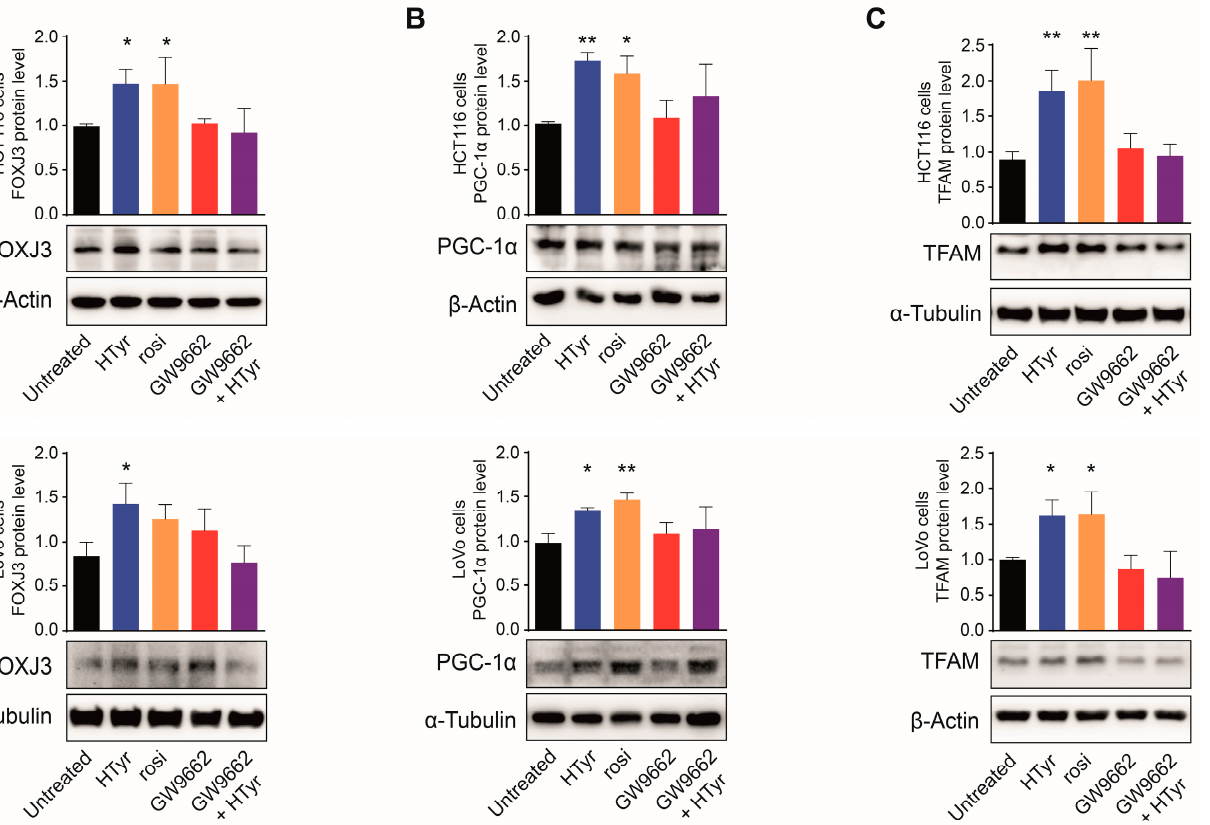
Figure 5. PPAR γ mediates the effects of HTyr on mitochondrial biogenesis. Representative im- munoblots of FOXJ3 ( A ), PGC-1 α ( B ), and TFAM ( C ), as markers of mitochondrial biogenesis in HCT116 and LoVo cells untreated or treated with HTyr, rosi, GW9662 or the GW9662 + HTyr combined treatment. The results are expressed as protein levels after normalization to β -Actin or α -Tubulin, used as loading controls, from three independent experiments. Statistical significance was considered when * p < 0.05 or ** p < 0.01 (ANOVA with Dunnett’s